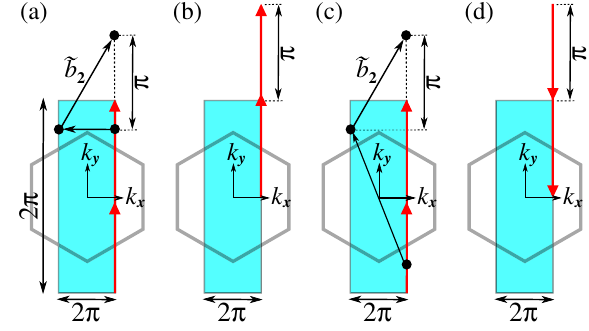
FIG. 10. Origin of W -glide and W -time-reversal symmetries. (a) – (d) Constant- k slices of the bulk Brillouin zone. Panel z ¯ M (a) illustrates how the glide ( ) maps momenta from the glide x π . Under ¯ M plane k , the Wilson loop is mapped from the red x ¼ x vertical arrow in (a) to the red vertical arrow in (b). Panels (c) and 0 plane and illustrate a similar story for the (d) describe the k z ¼ time reversal T